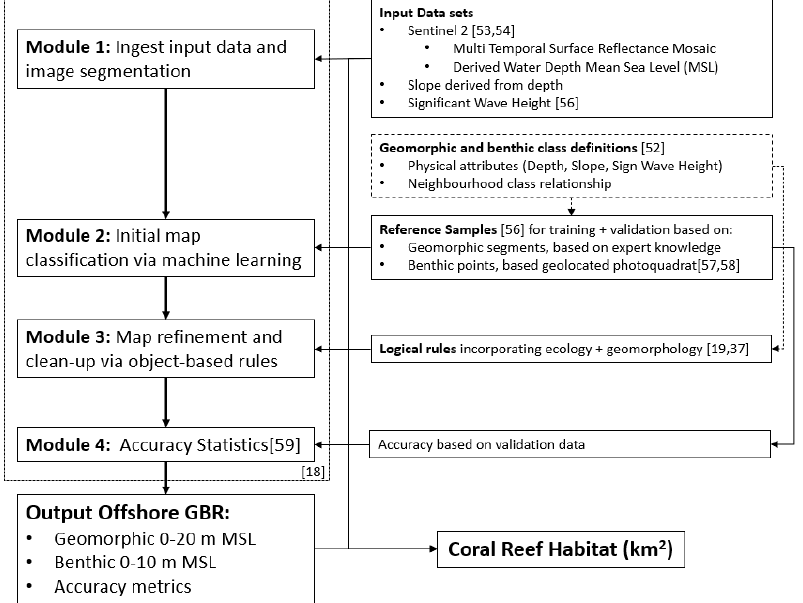
Figure 2. Flowchart conceptualizing the four modules for mapping geomorphic and benthic cate- gories with refinements for the shallow offshore Great Barrier Reefs, using specific input datasets. Framework adapted from Reference [18].